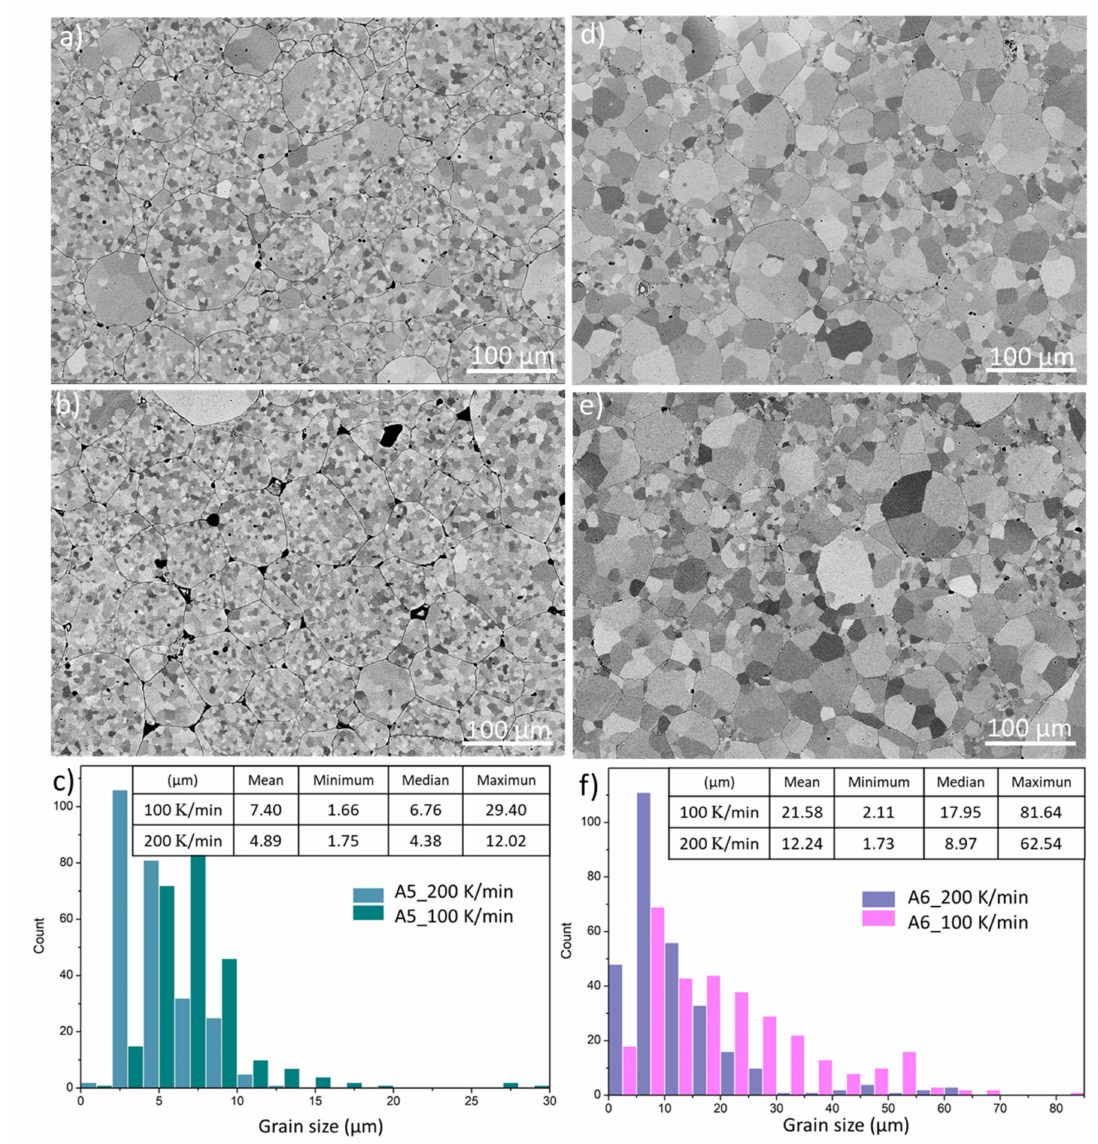
Figure 3. ( a , b ) Microstructures of A5 sintered alloy at 100 and 200 K/min, respectively; ( d , e ) Microstructures of A6 sintered alloy at 100 and 200 K/min, respectively; and ( c , f ) comparison of grain size distribution of alloys sintered at different heating